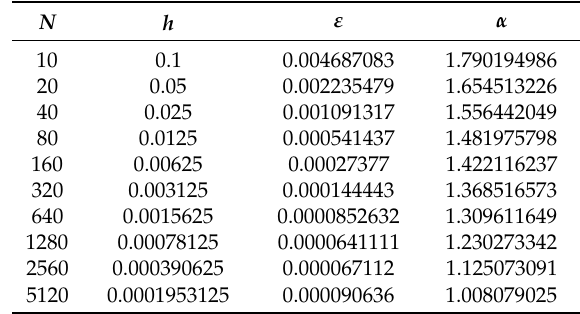
Table 1. Results of the study of the computational accuracy of the method (6).